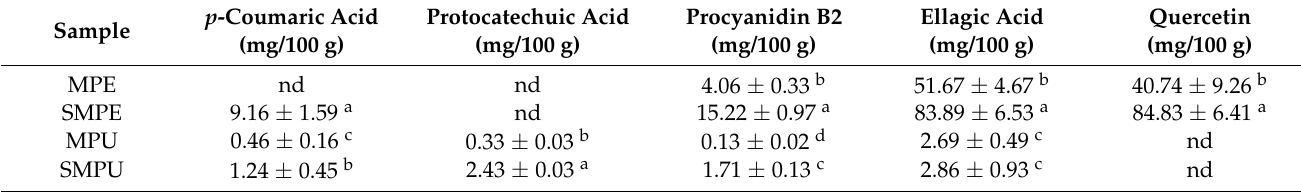
Table 4. Phenolics contents of umbu pulps and peels flours.